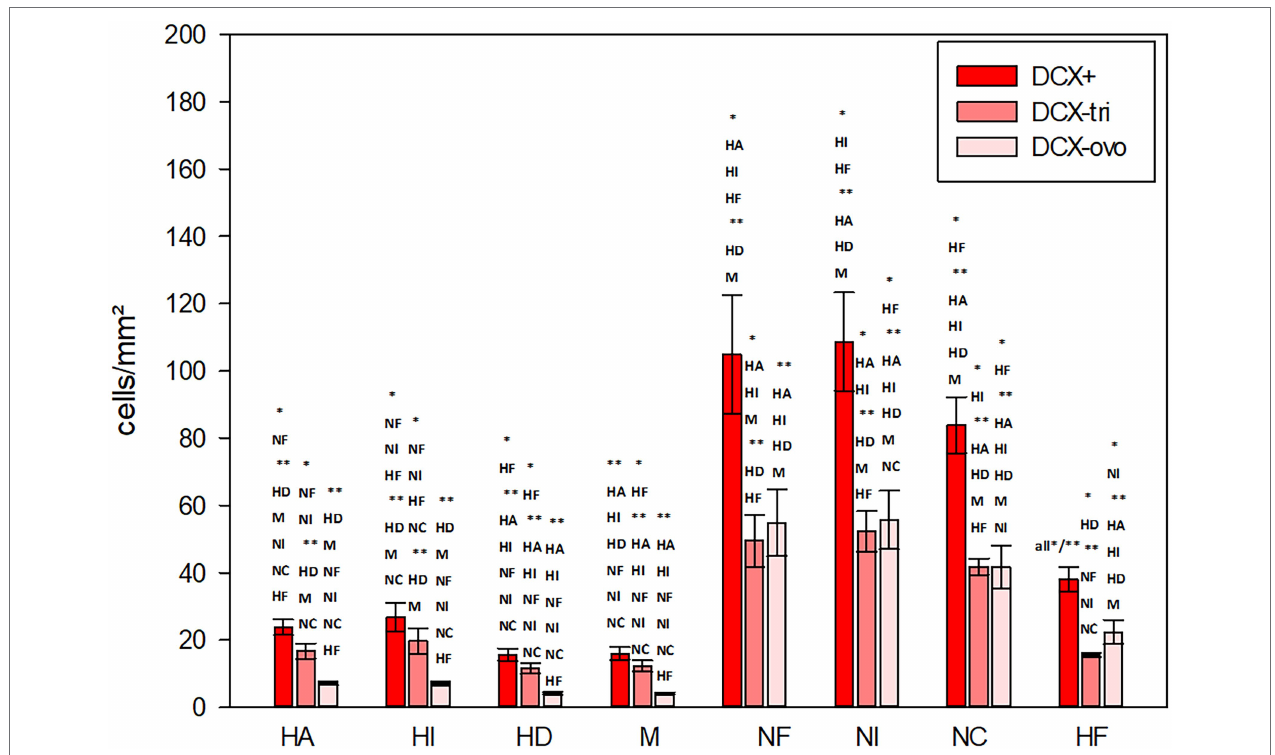
FIGURE 11 | Distribution of DCX+ cells/mm 2 in different regions of the telencephalon of the pigeon. Two different types of DCX+ cells were recognized, triangular ( − tri) and ovoid ( − ovo) cells. Bars represent mean ± SE. Asterisks indicate significant differences (Wilcoxon Signed Rank Test, * p < 0.05, ** p <